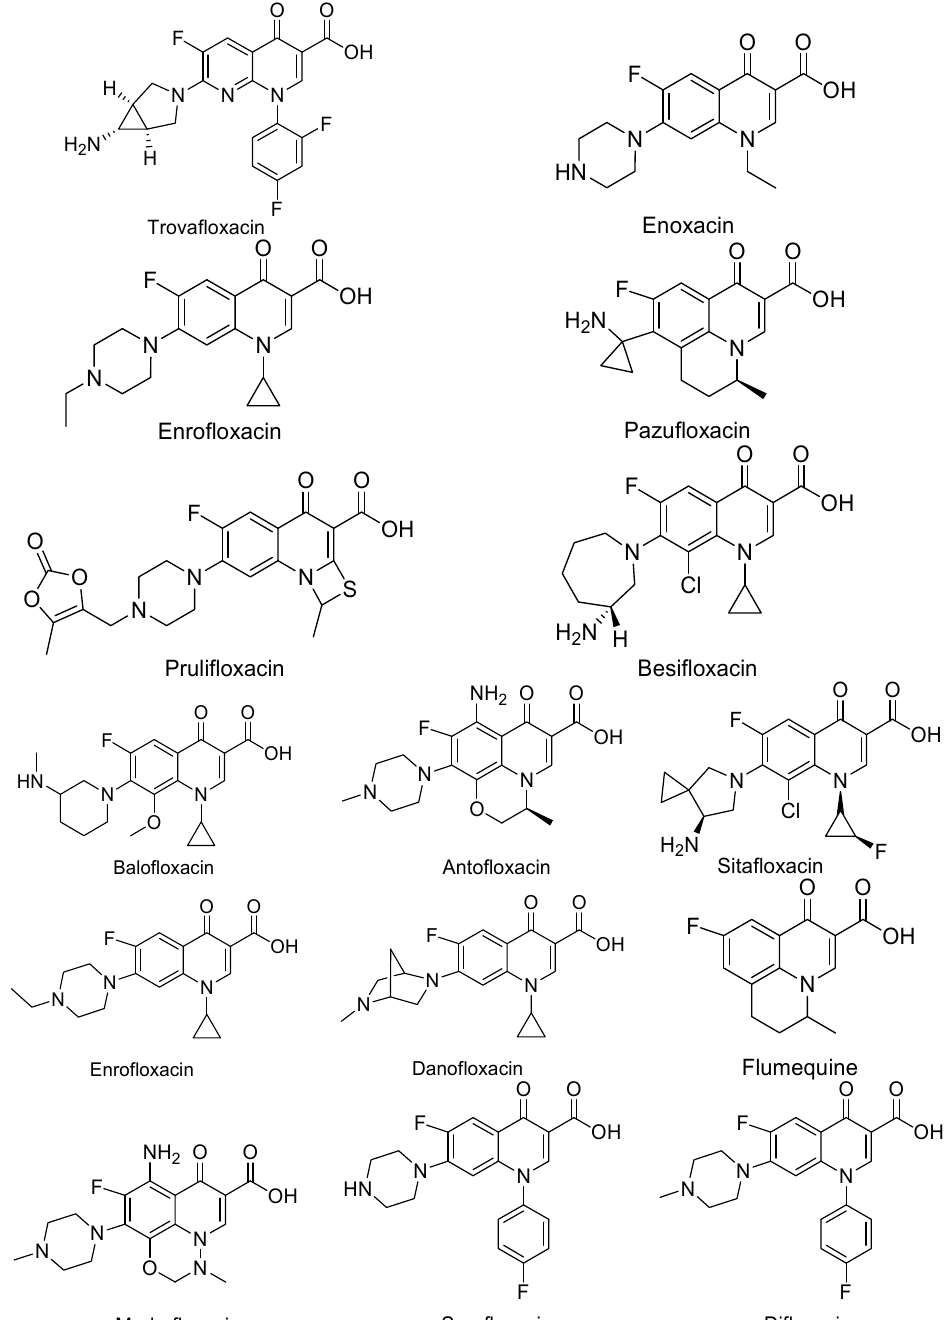
Figure 2. Common analogues of quinolones used for the treatment of different diseases.